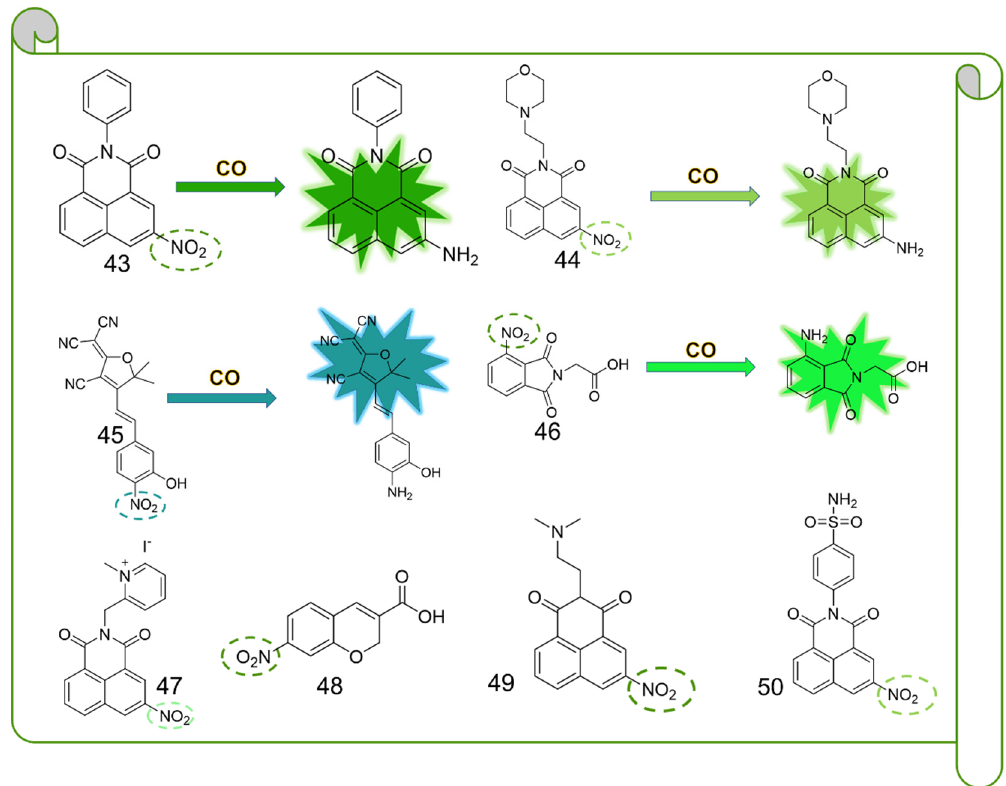
Figure 17. A number of fluorescent probes for the detection of CO and nitro as a recognition group.